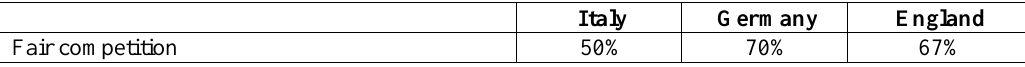
Table 8: Standard Conduct/Behaviour in Relationships with Competitors Fair